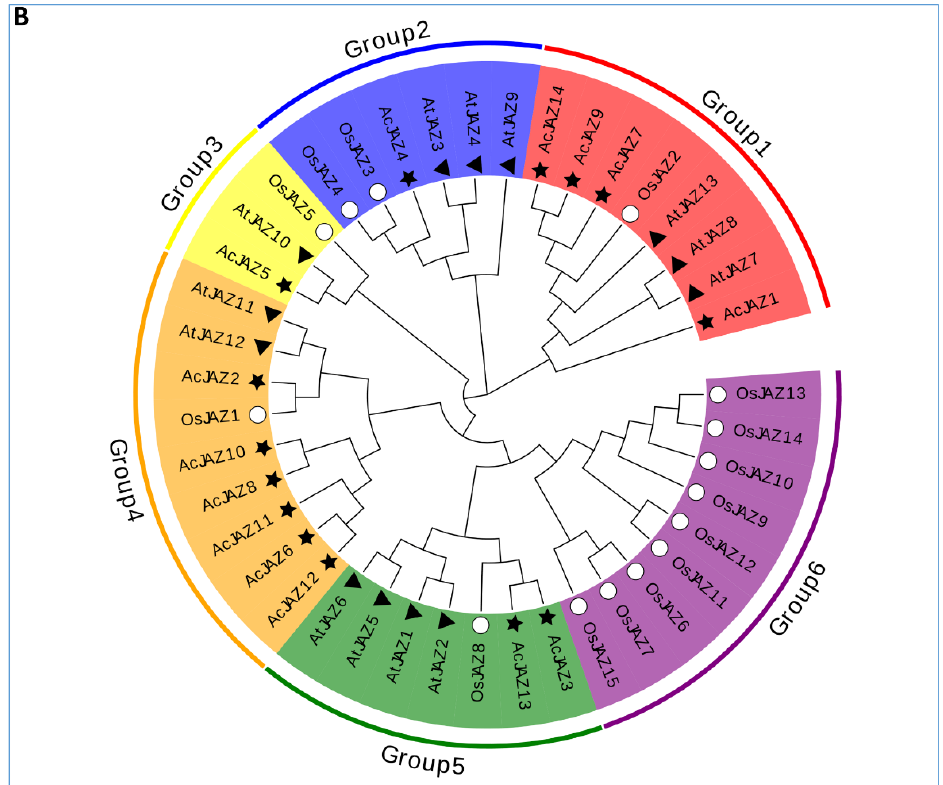
Figure 1. The JAZ gene family in pineapple. ( A ) Chromosomal locations of JAZ genes in pineapple. The respective chromosome number is indicated by different colors at the top of each chromosome. The scale on the left is for chromosomes in megabases ( B ) Phylogenetic relationship of JAZ proteins from Arabidopsis thaliana , Oryza sativa , and pineapple. The phylogenetic tree was created using the neighbor-joining method with 1000 bootstrap replicates by MEGA 7. The diverse groups of JAZ proteins are marked with different colors. The JAZ proteins of A. thaliana , O. sativa , and pineapple are represented by black triangles, white circles, and black stars, respectively.